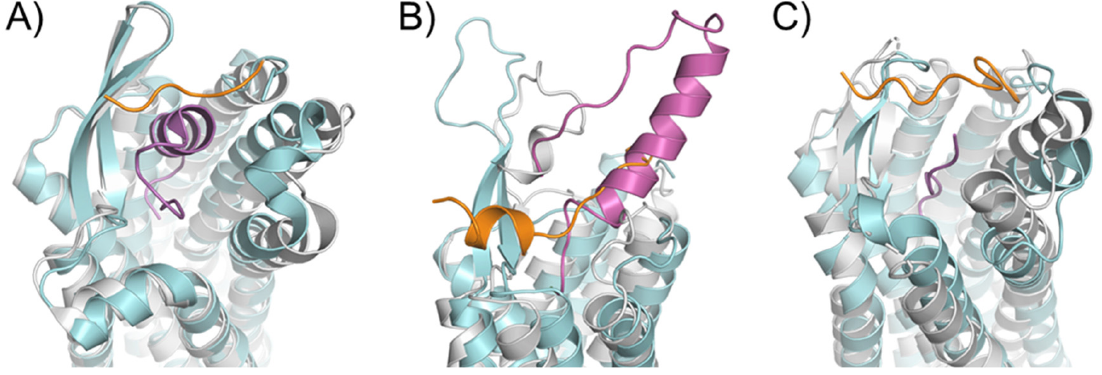
Figure 3. Rearrangements in the extracellular domain of peptide-activated GPCRs for peptide binding. ( A ) In the apo ET-B receptor (grey, PDB ID 5GLI), the N-terminus (orange) is lying over the ligand binding pocket. In the ET-1-bound state (cyan, PDB ID 5GLH), the bound ET-1 ligand (magenta) occupies the space of the N-terminus leading to its displacement [55]. ( B ) The crystal structure of antagonist-bound Y 1 receptor (grey, PDB ID 5ZBQ) is also found with the N-terminus (orange) lying over the ligand binding pocket. The modeled peptide-bound Y1R (cyan) places the NPY ligand (magenta) in this space displacing the N-terminus [56]. ( C ) In the antagonist bound AT1 receptor (grey), the N-terminus (orange) extends over the pocket towards ECL2 [66]. In the AT2 receptor (cyan) bound to sAngII (magenta), the peptide binds deep within the pocket and the N-terminus lies over ECL3 [53].